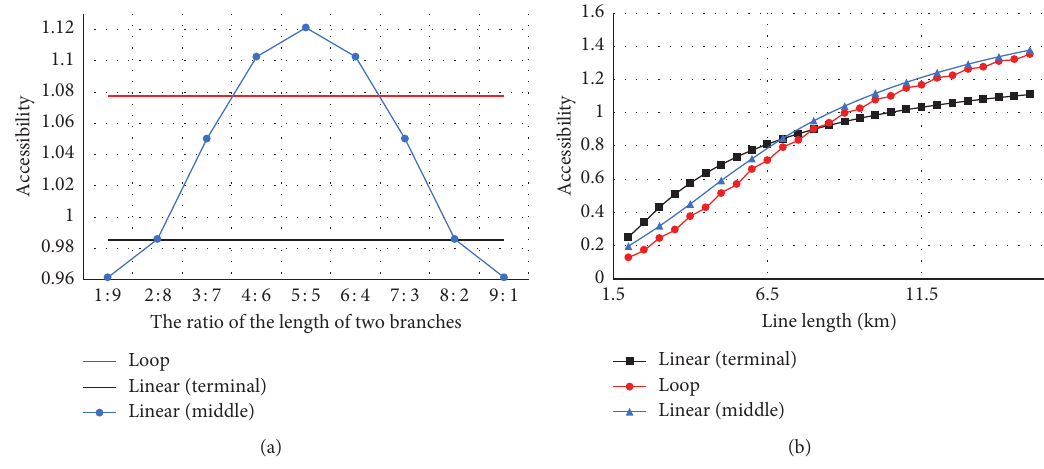
Figure 8: The impact of the location of the transfer stop on the accessibility of a linear line. Table 3: The parameters involved in the